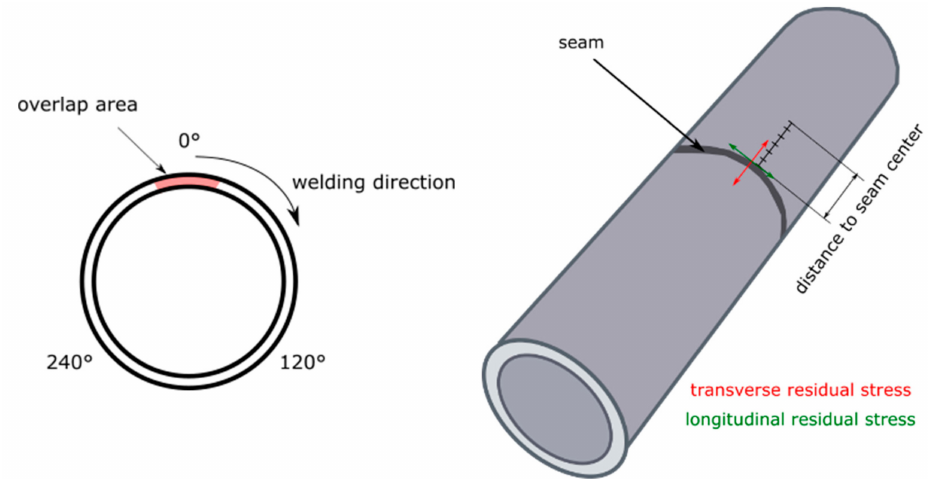
Figure 2. Measuring points of the residual stress.